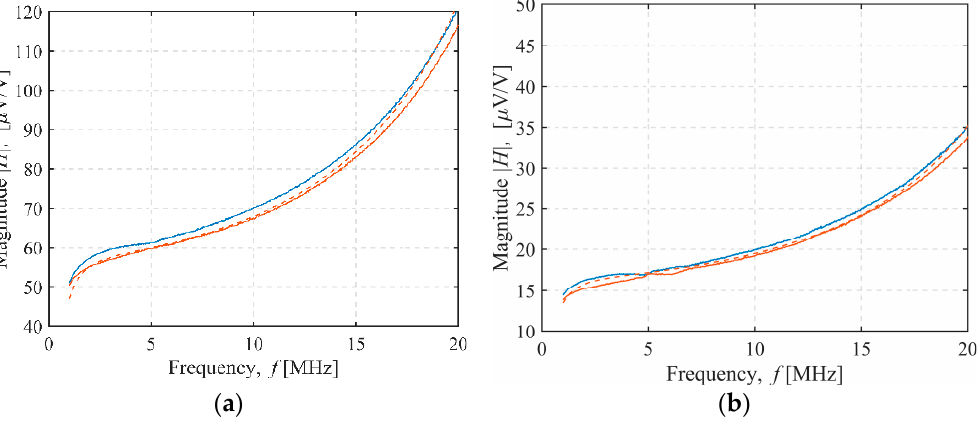
Figure 8. TX C-2/RX C-2 configuration sensor transfer function magnitude. Transmitter–receiver separation: ( a ) 27 cm, ( b ) 37 cm. Measurement (full line) and model results (dashed line). Transmitter orientation up (blue line) or down (red line).